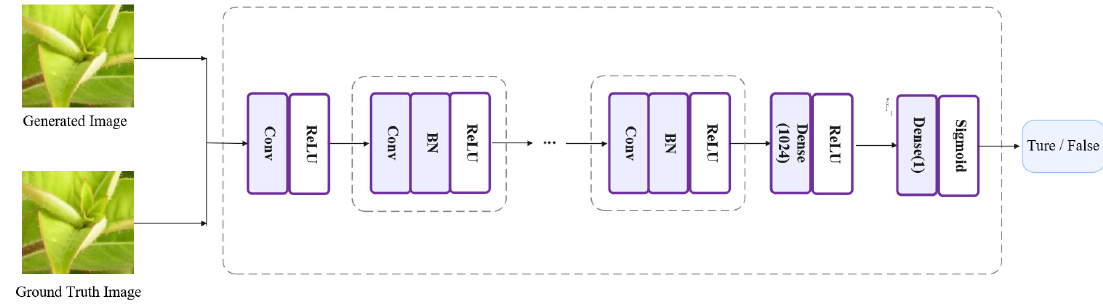
Figure 4. Discriminator structure.